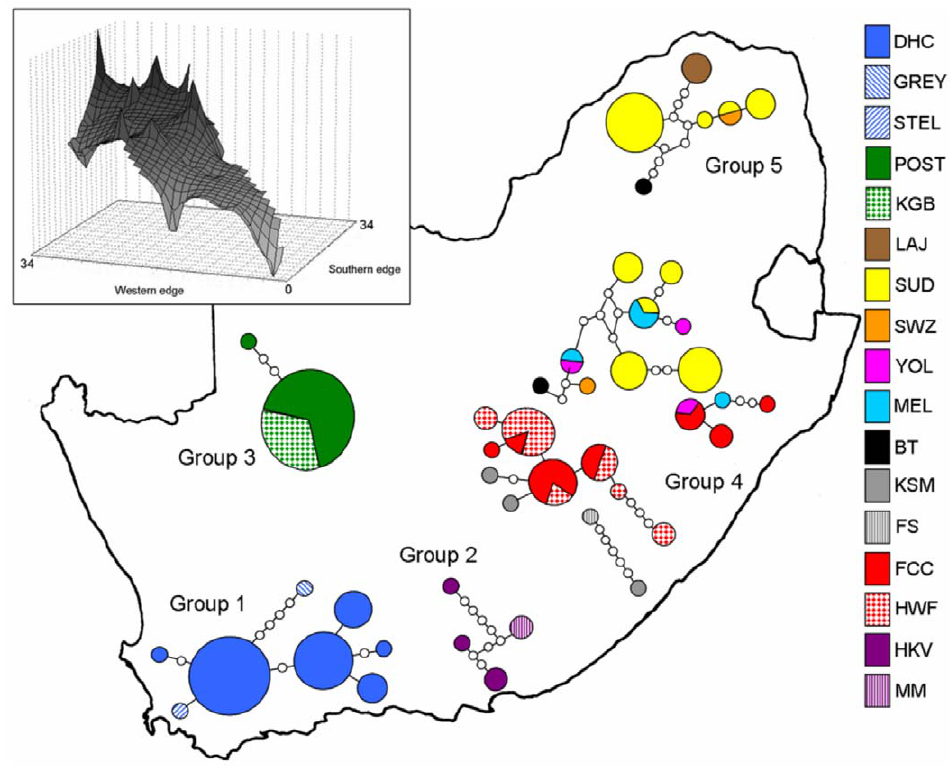
Figure 3. Minimum spanning network (95% threshold) for South African bats (including two individuals from Swaziland). Circle size represents haplotype frequency and patterns indicate the sampling locality for the proportion of individuals with that haplotype. Sampling locality codes are the same as in Figure 2 and Table 1. The inset shows the graphical interpolation-based representation of the genetic structure obtained over a South African landscape. Darker grey is indicative of high genetic diversity and lighter grey, of lower genetic diversity.